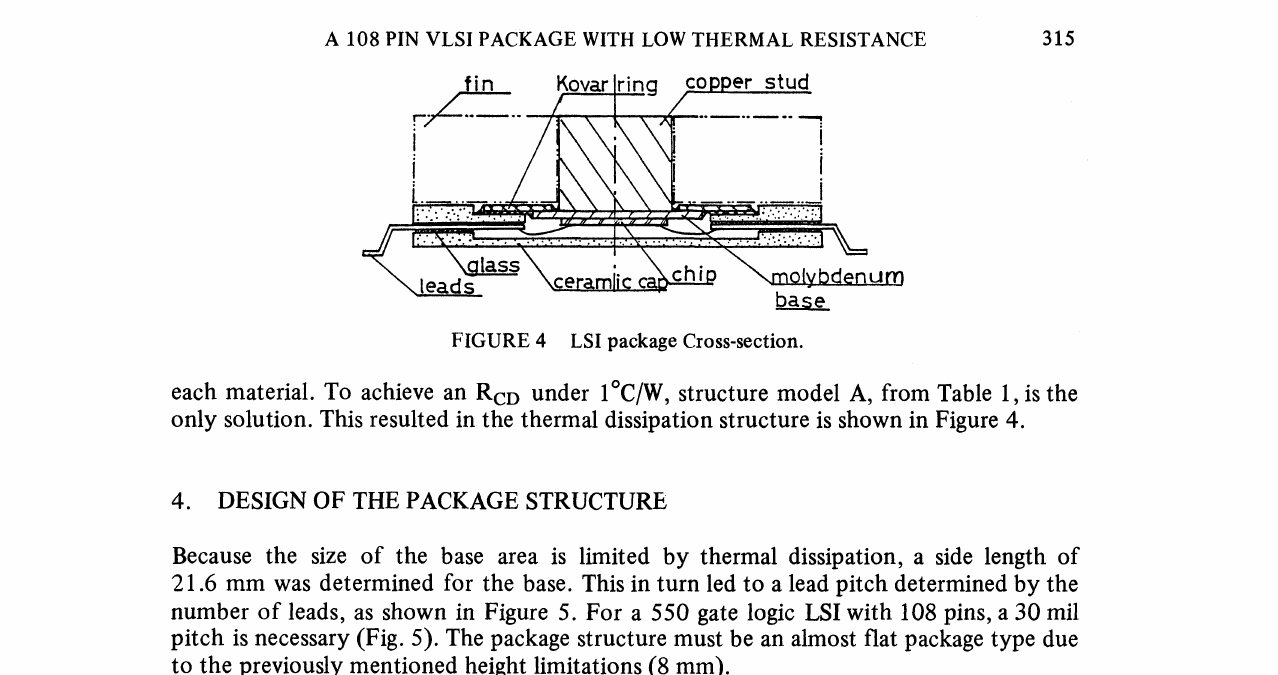
FIGURE 4 LSI package Cross-section.